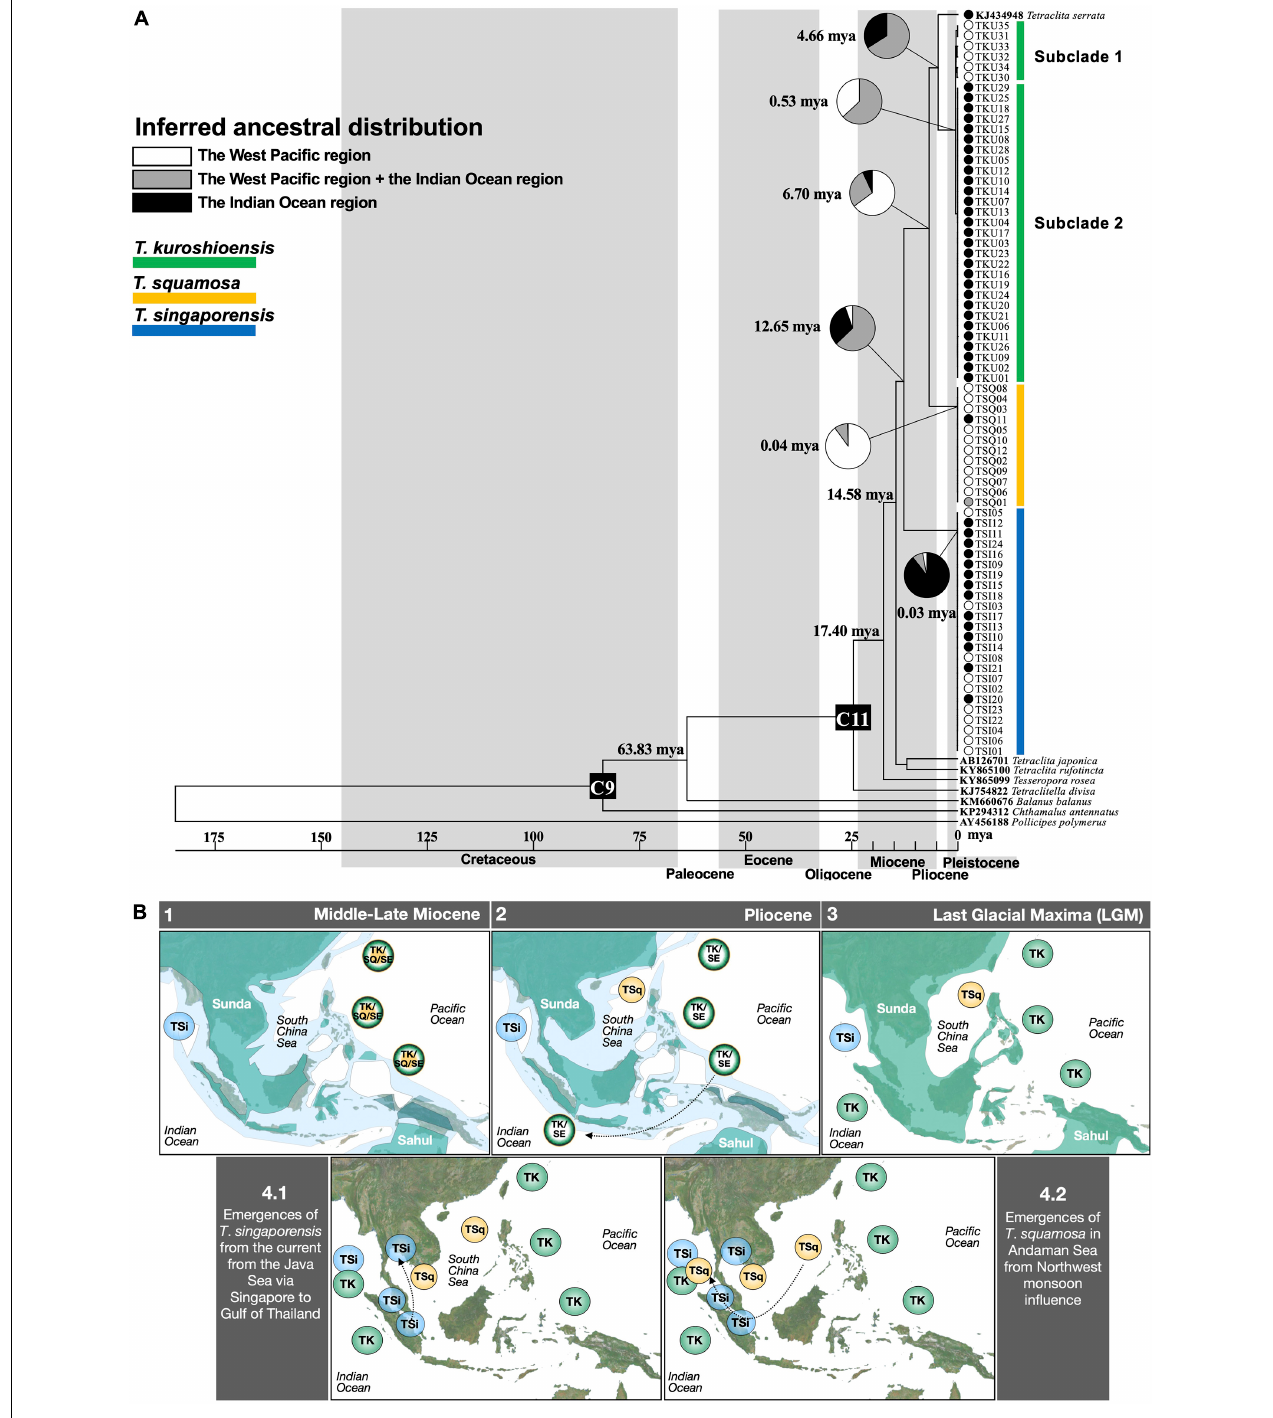
FIGURE 5 | (A) Ancestral distributions inferred by statistical dispersal-vicariance analysis (S-DIVA) and divergence time. The probabilities of alternative ancestral ranges at each node are in different colors in the pie charts. The divergence times (million years ago) estimated by RealTime-ML analysis are also shown at the main nodes. C9 stands for the calibration point of the fossils of Pachydiadema ( Catophragmus ) cretacea . C11 stands for the calibration point of the fossils Tetraclitella judiciae . These two calibration points were used in Pérez-Losada et al. (2008). (B) Paleobiogeography hypothesis of Tetraclita distribution around the Sunda Shelf from the Middle-Late Miocene to present day. LGM and date of sea fluctuation are adapted from Crandall et al. (2012). See the Discussion section for detail. Green indicates the exposed land. Green in (3) indicates the region that was an exposed landmass during the Pleistocene glaciations. Light blue indicate shallow seas. Location of landmass in different geological time followed Hall (1998). TK, Tetraclita kuroshioensis ; TSi, Tetraclita singaporensis ; TSq, Tetraclita squamosa ; TK/SQ/SE, common ancestor of T. kuroshioensis , T. squamosa and T. serrata ; TK/SE, common ancestor of T. kuroshioensis and T. serrata .